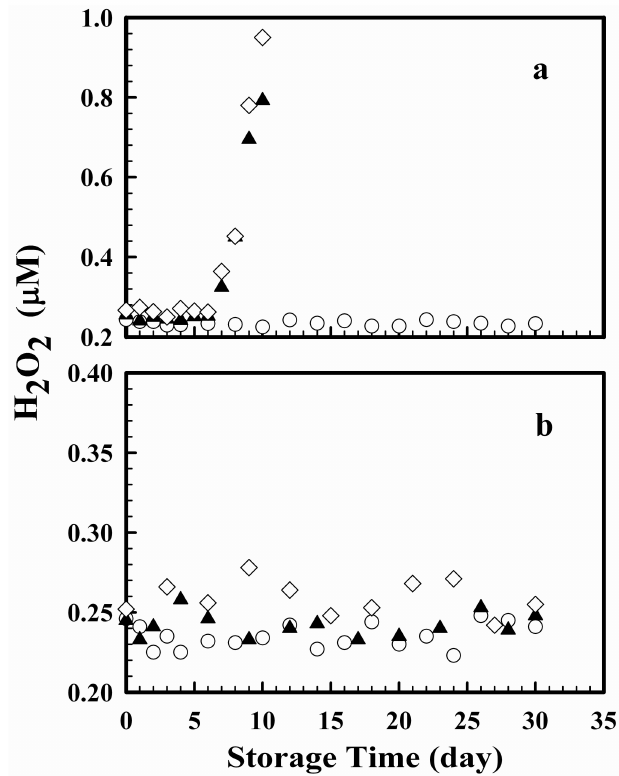
Figure 5. Variations in the concentration of H 2 O 2 in reagent grade water